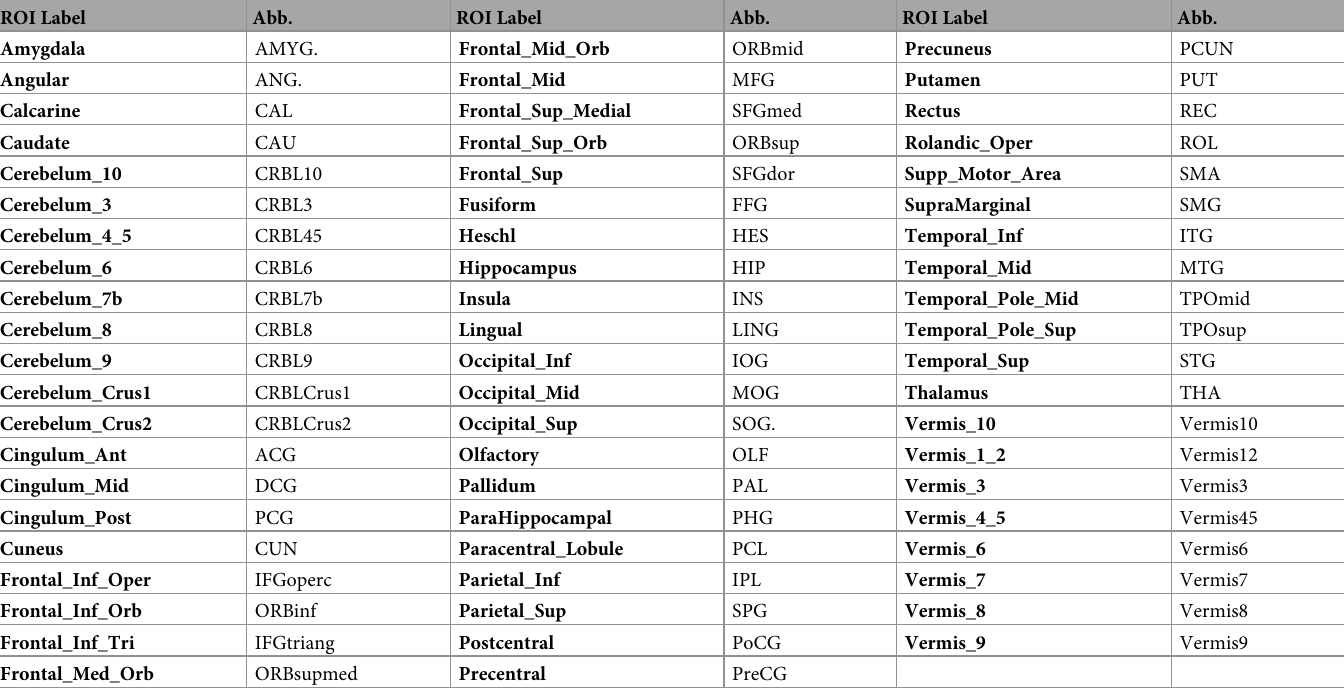
Table 2. The ROIs extracted from the different based on 116 AAL template. ROI Label Abb. ROI Label Abb. ROI Label Abb.